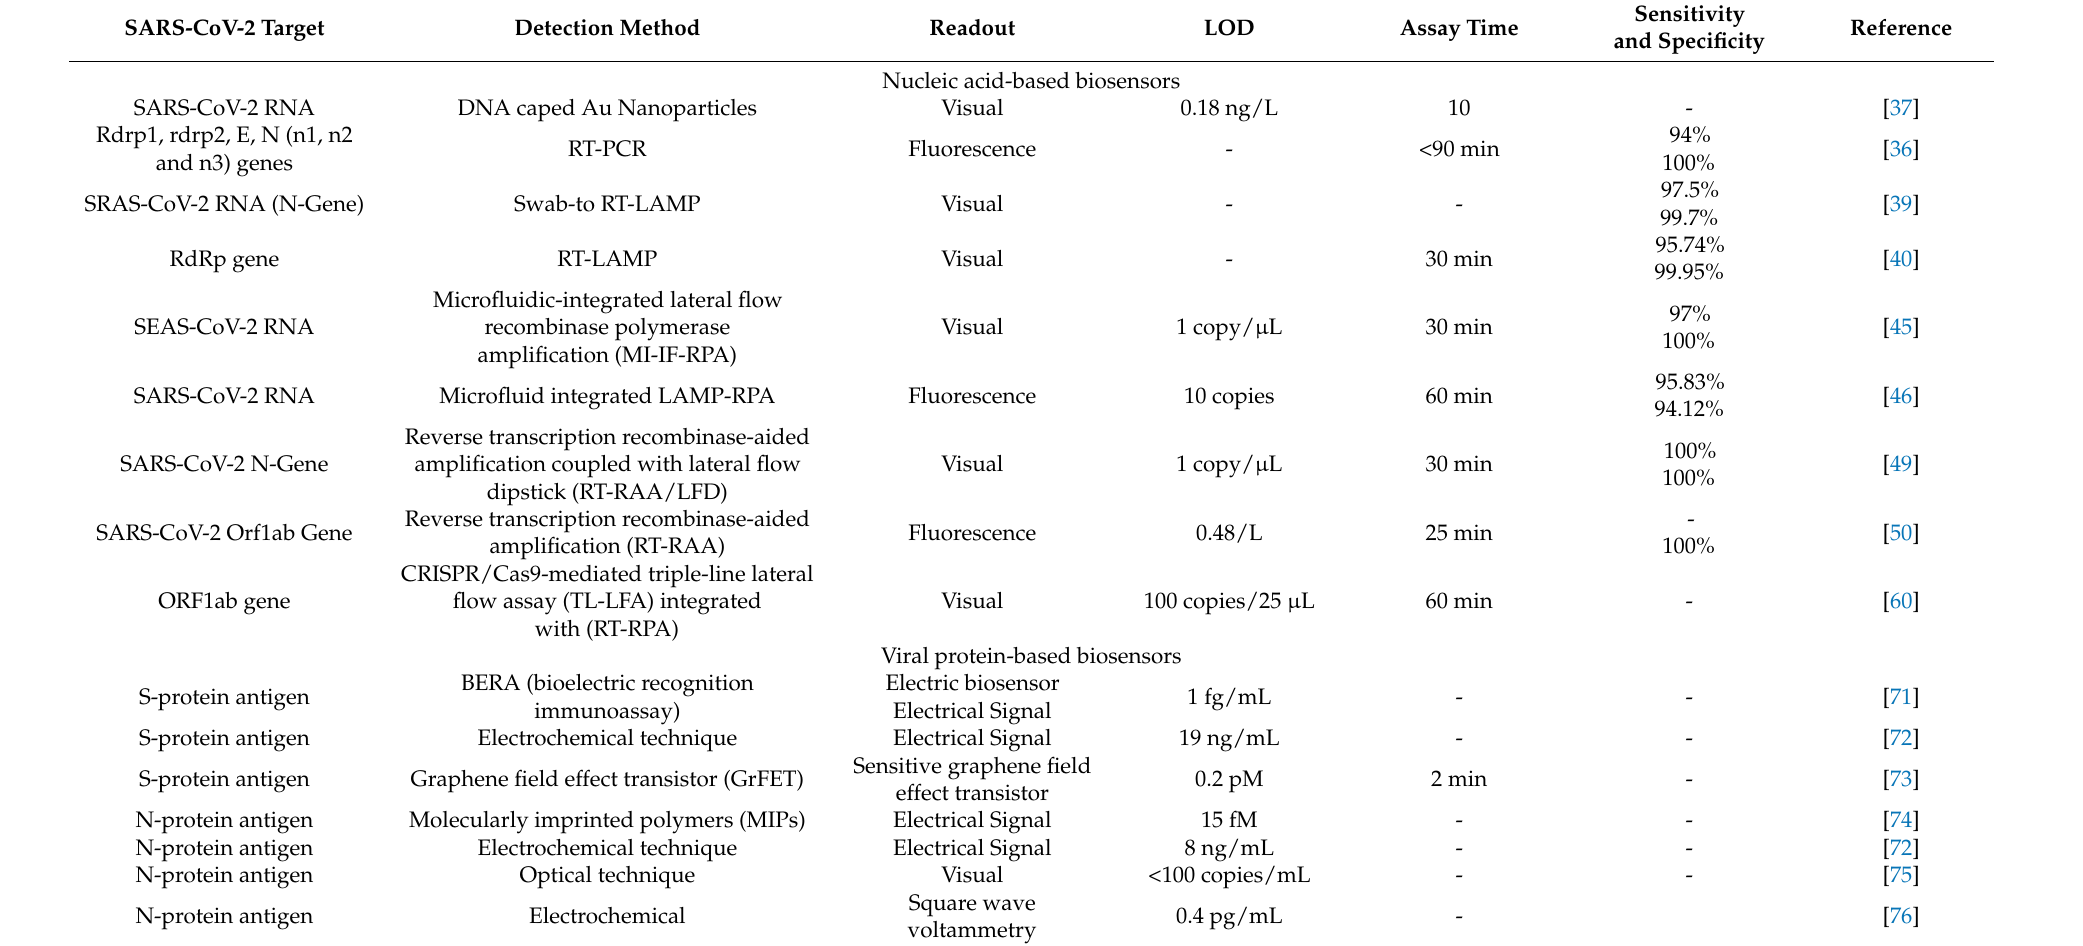
Table 1. Various Biosensors developed for SARS-CoV-2